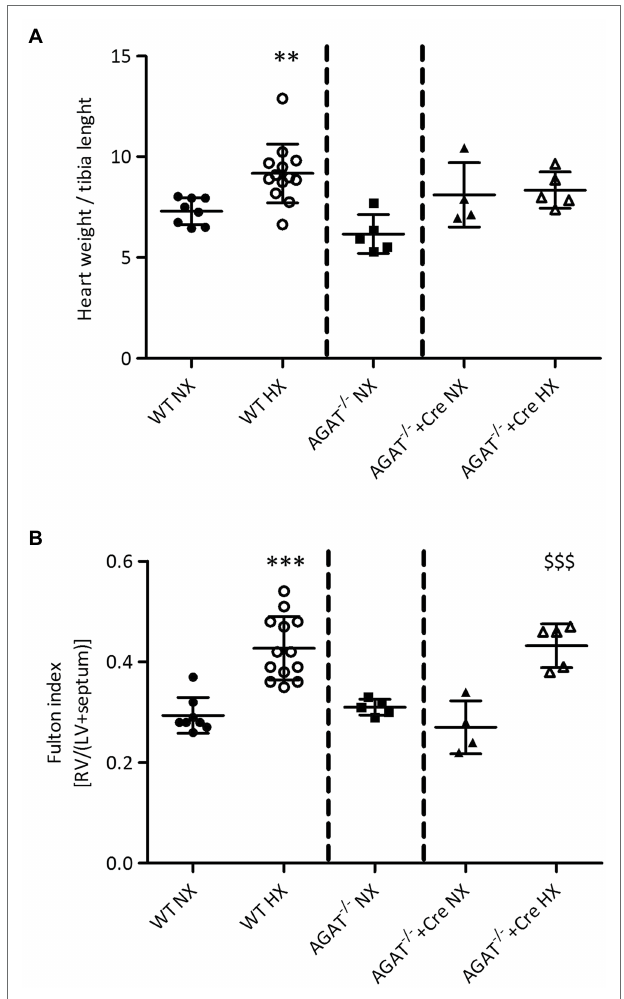
FIGURE 4 | Phenotypes of cardiac hypertrophy of Agat − / − mice and WT littermates. (A,B) Mean values ± SD from hearts from Agat − / − mice supplemented with 1% creatine and WT littermates (WT) under normoxia (NX) and after 4 weeks of hypoxia (HX). (A) Heart weight to tibia length. (B) Fulton index {right ventricle (RV) weight/[left ventricle (LV) + septum weight]}. Agat , arginine:glycine amidinotransferase; Cre, supplemented with 1% creatine. ** p < 0.01 vs. WT NX, *** p < 0.001 vs. WT NX, $$$ p < 0.001 vs. Agat − / − +Cre NX (ANOVA with Bonferroni post-hoc